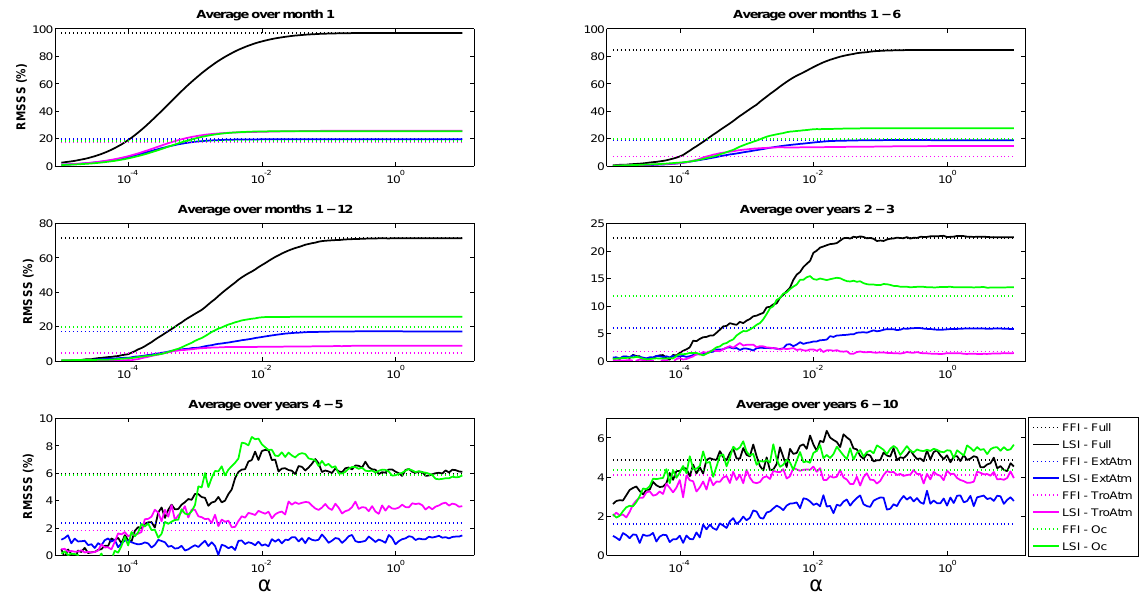
Fig. 6. RMSSS as a function of the tuning coefficient α for LSI (see text). The six panels refer to six different averaging periods and are indicated in the corresponding labels. Different colors represent the case of the initialization of the full system (black), ocean (green), tropical atmosphere (purple) and extratropical atmosphere (blue). The values of the standard FFI are displayed for reference